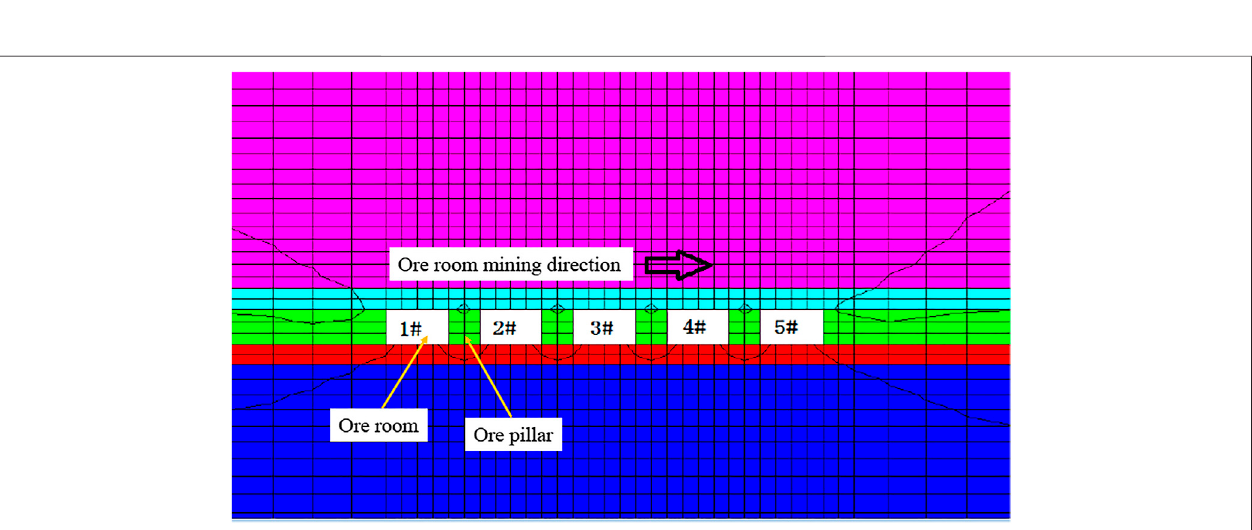
FIGURE 2 | Structure and size of rooms and pillars. (A) Room and pillar mining and back fi ll mining. (B) Caving mining.